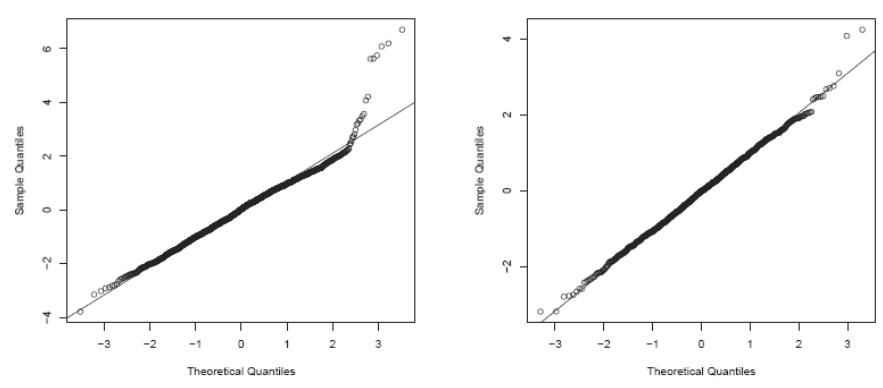
Figure 4 – Normal probability plot of randomized residuals for the base model M 0 (left) and the final model M 1